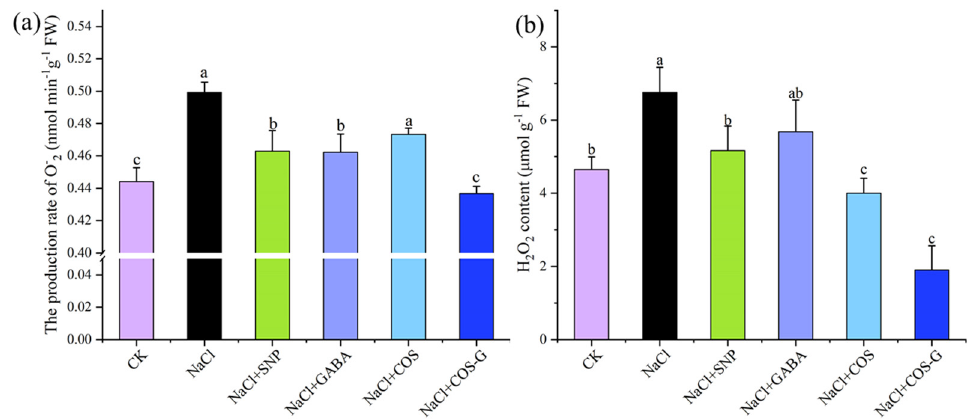
Figure 6. Effects of different treatment groups on O − 2 and H 2 O 2 content in wheat seedling leaves under salt stress. ( a ) the production rate of O − 2 ;( b ) H 2 O 2 content. Values are the mean ± SD of three replicates in independent experiments. Different letters ( a,b,c… ) indicate significant differences at p < 0.05 on the same parameter.